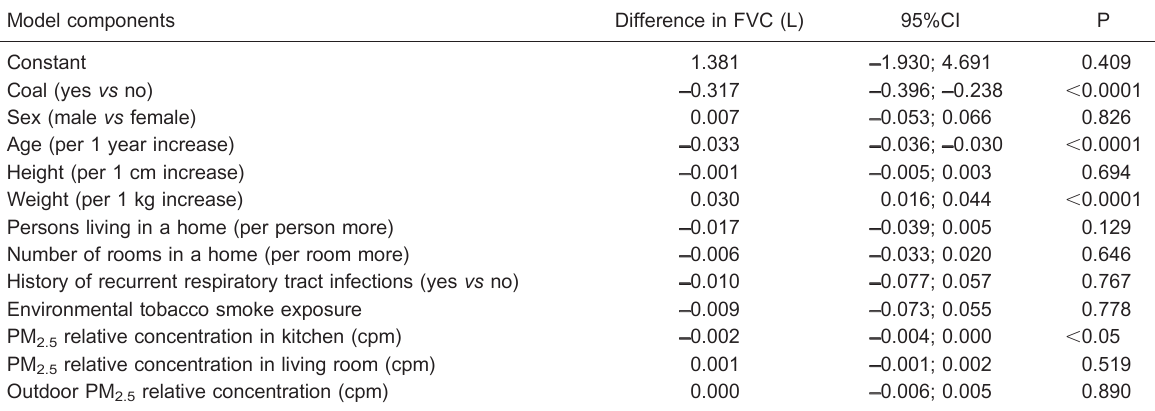
Table 2. Estimated parameters and 95% confidence interval (CI) of multivariate linear regression analysis of forced vital capacity (FVC). Model